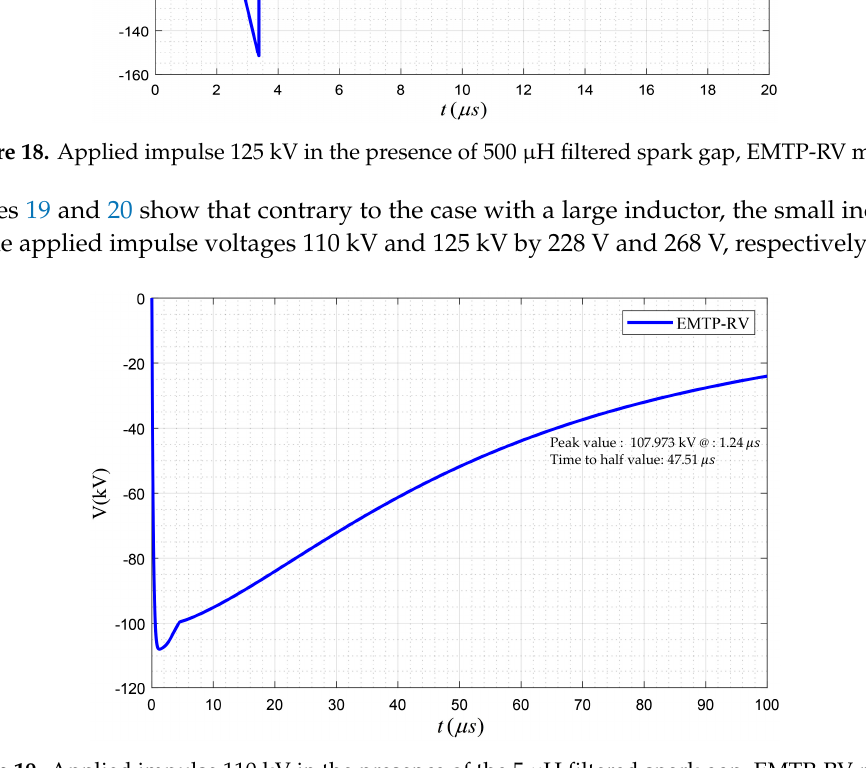
Figure 19. Applied impulse 110 kV in the presence of the 5 μH filtered spark gap, EMTP-RV model.